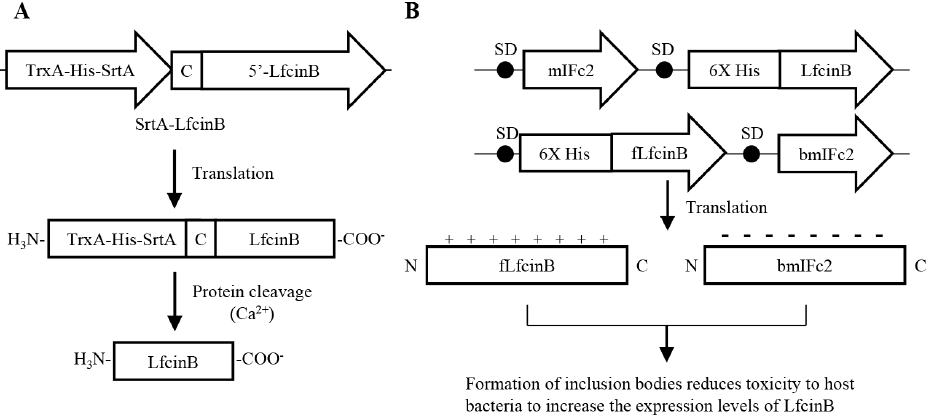
Figure 1. Two different expression systems for expression of LfcinB. ( A ). The transferase active region SrtA of Staphylococcus aureus was fused with LfcinB. After expression of this SrtA-LfcinB fusion protein, the enzyme activity of SrtA can be used to induce self-cleavage and release of LfcinB in presence of Ca 2+ . ( B ) Diagrams of the LfcinB two-cistron co-expression system. The two different gene orders of LfcinB and mIFc2 are shown at top of the panel.